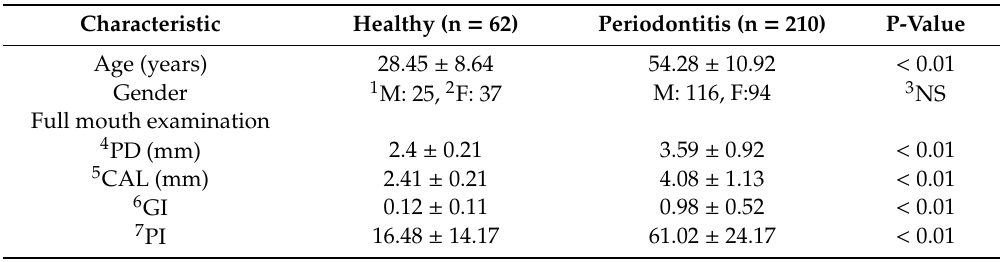
Table 1. Demographic characteristics and clinical parameters of healthy subjects and patients with periodontitis (mean ± standard deviation). Characteristic Healthy (n = 62) Periodontitis (n = 210) P-Value Age (years) 28.45 ± 8.64 54.28 ± 10.92 < 0.01 Gender 1 M: 25, 2 F: 37 M: 116, F:94 3